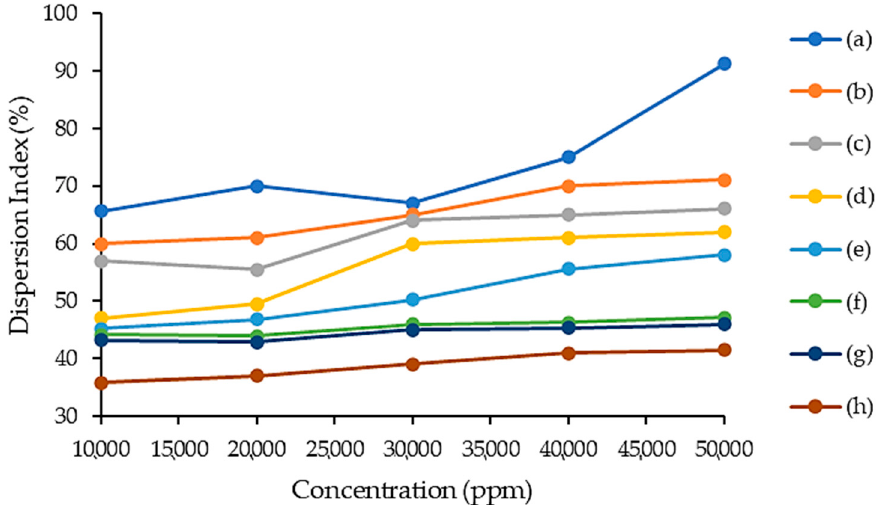
Figure 7. IL concentration effect for asphaltene study. (a) [C 16 C 1 Pip] 2 [LS], (b) [C 12 C 1 Pip] 2 [LS], (c) [C 8 C1Pip] 2 [LS], (d) [C 6 C 1 Pip] 2 [LS] (e) [C 16 C 1 Pip][Cl], (f) [C 12 C 1 Pip][Cl], (g) [C 8 C 1 Pip][Cl], (h) [C 6 C 1